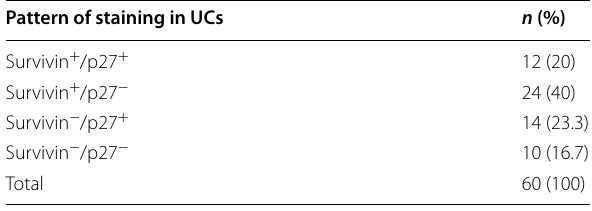
UC Urothelial carcinoma, n Number, % Percentage